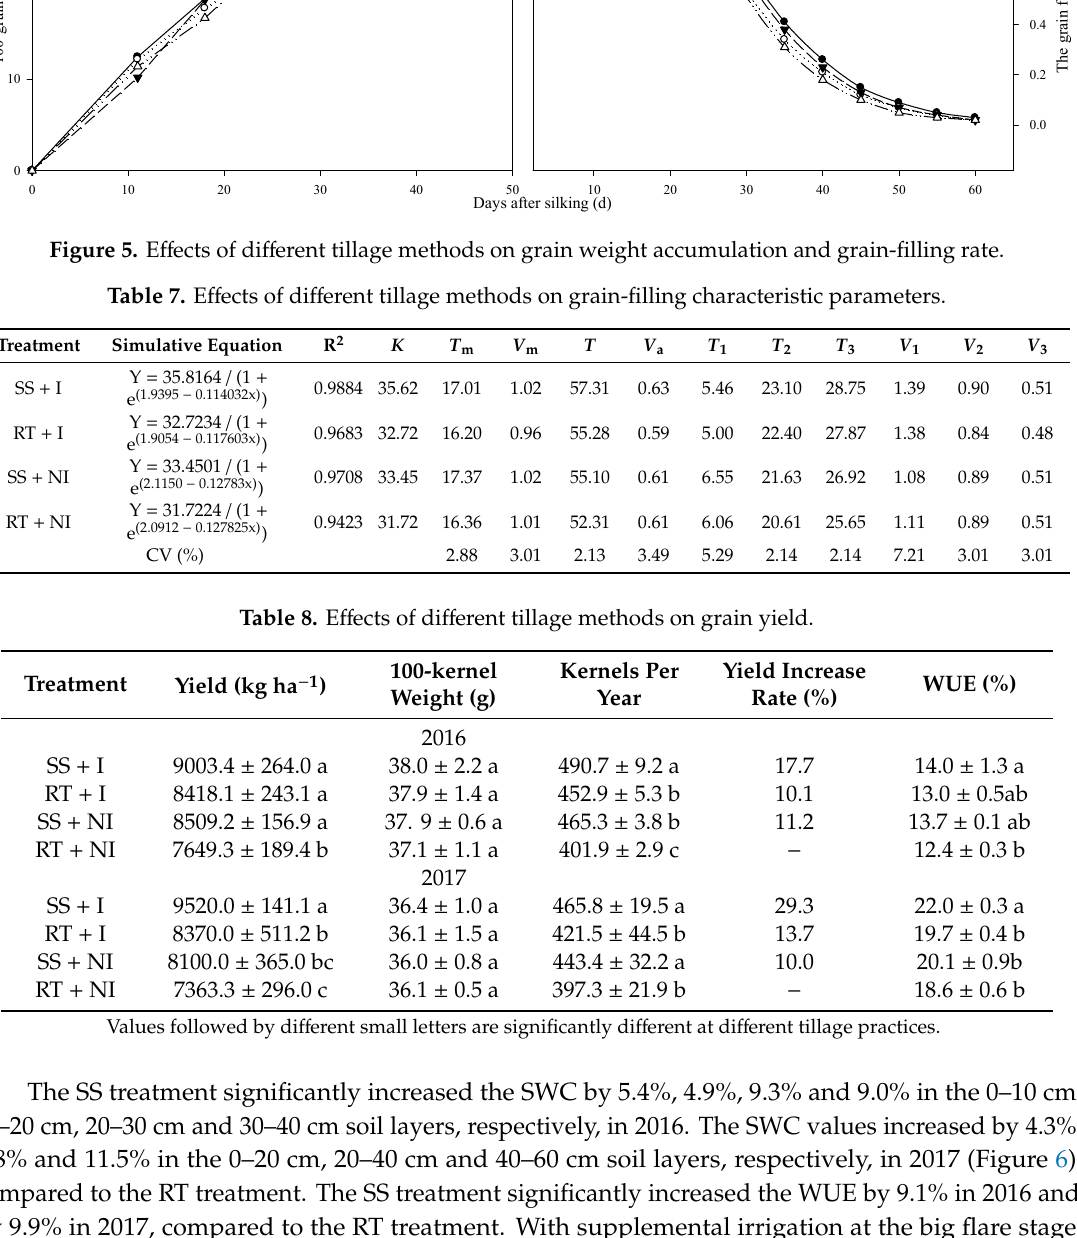
Table 8. Effects of different tillage methods on grain yield.